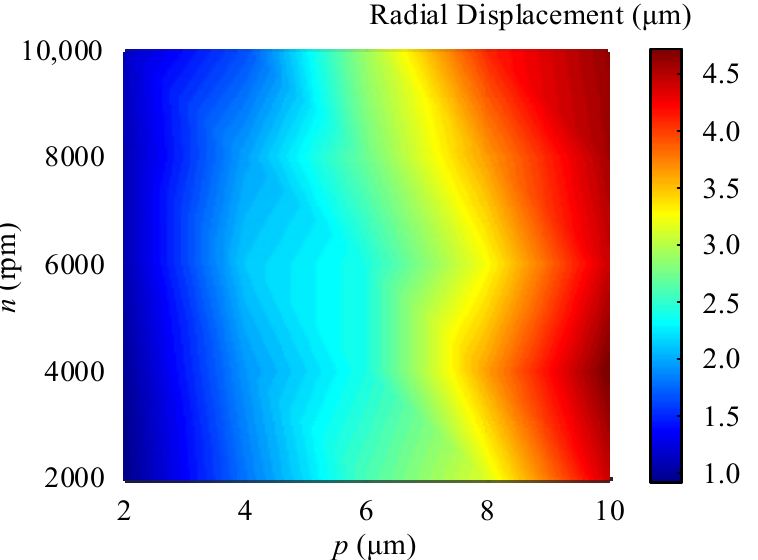
Figure 12. Variation law of radial displacement of DGB 6205 system with speed n and radial clearance p .